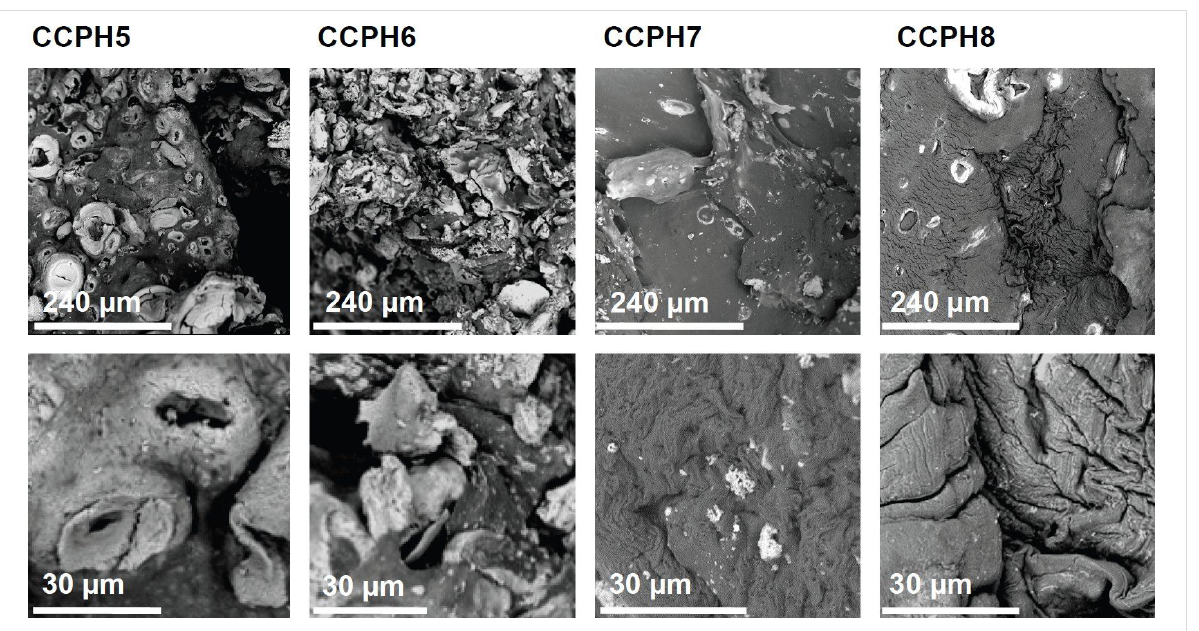
Figure 5: Low (top row) and high magnification (bottom row) SEM images of the hybrid materials prepared in the presence of